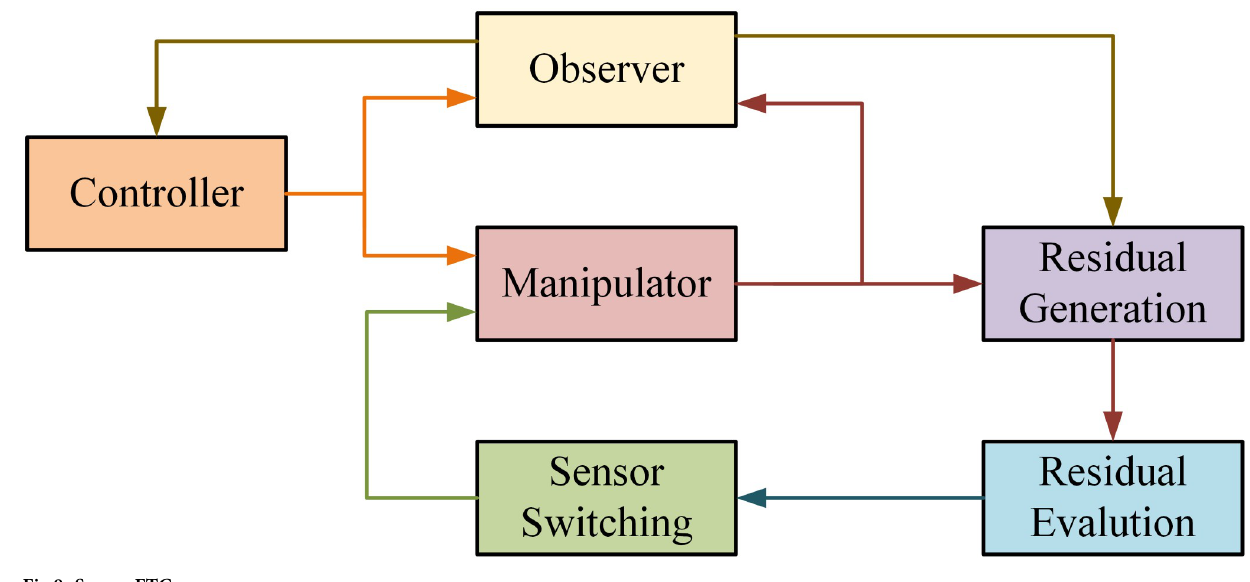
Fig 8. Sensor FTC.